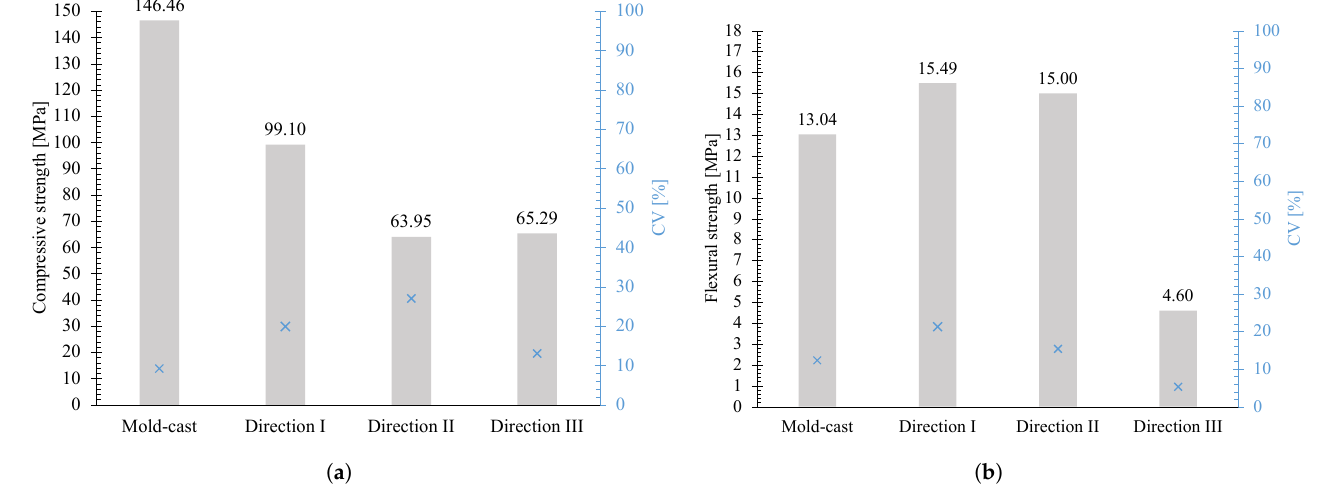
Figure 10. ( a ) Average compressive strength of the UHPC, and ( b ) Average flexural strength of the UHPC. The coefficients of variation (CV) are reported on the blue axis.